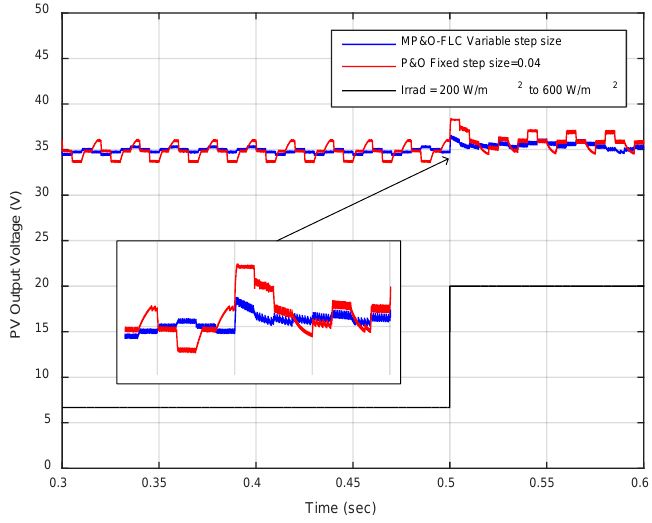
Figure 7. Comparison of PV voltage with fixed step size P&O MPPT and the proposed FLC-based variable step size P&O MPPT with a step change in solar irradiance.